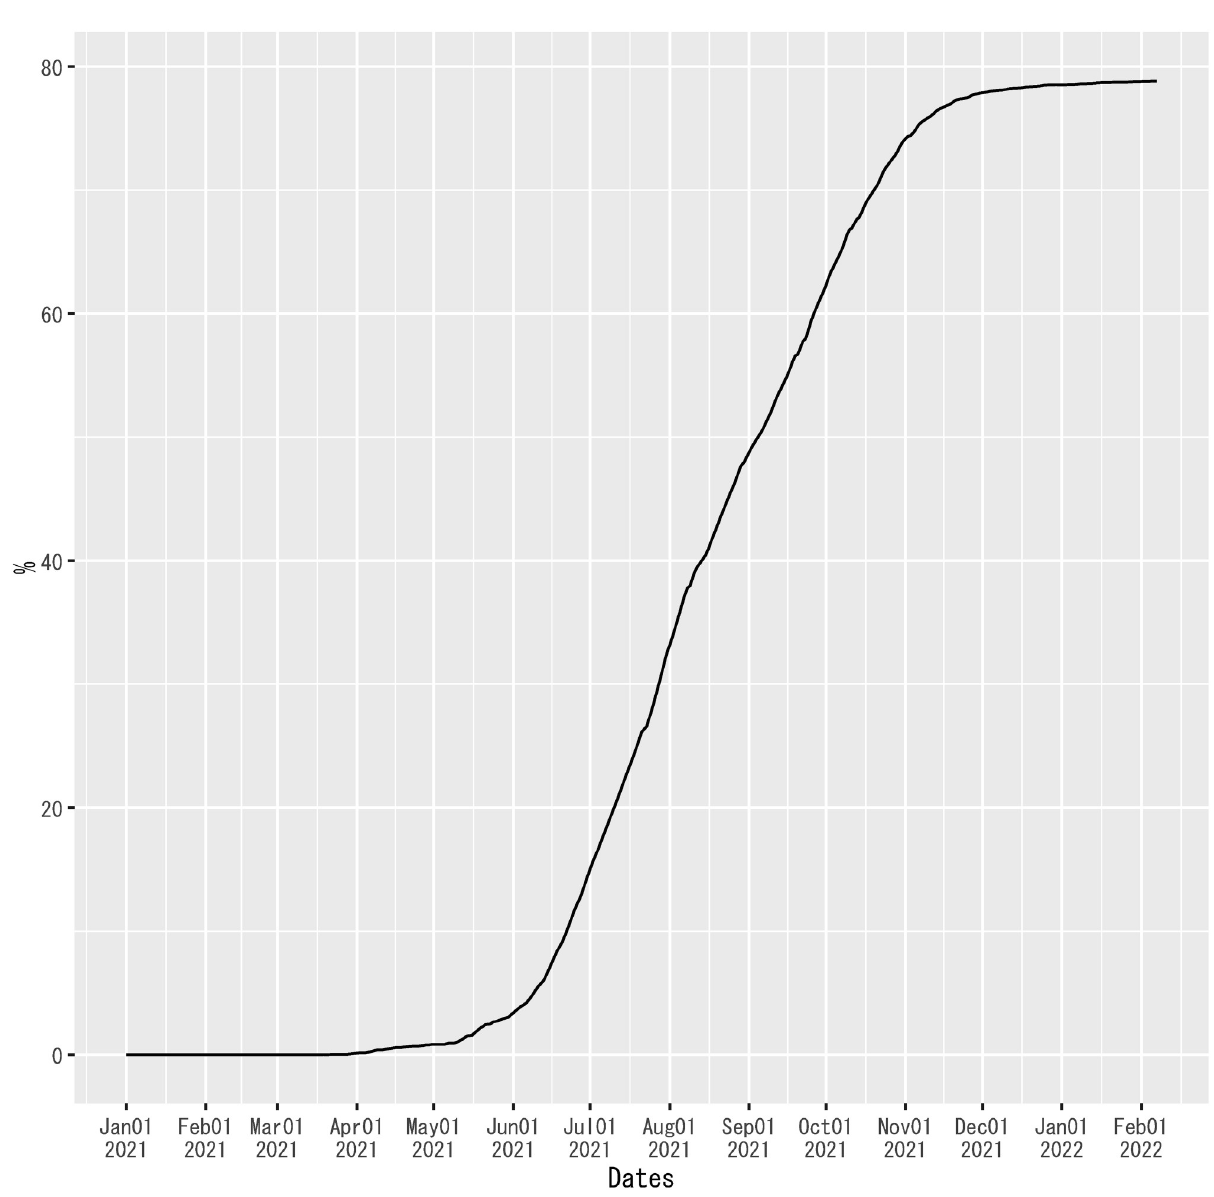
Fig 12. Twice-vaccinated share of the population in Japan. Source: The Ministry of Health, Labour and Welfare, the Government of Japan [60].